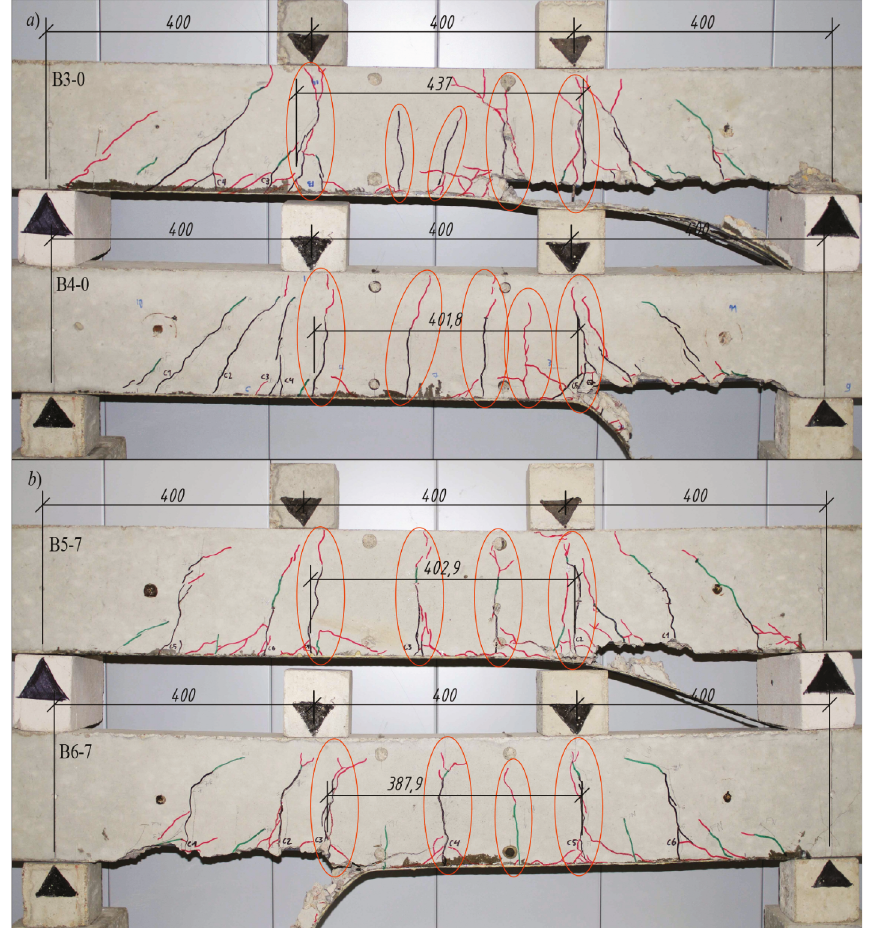
Figure 10: Experimental crack pattern of beams B3-0, B4-0, B5-7, and